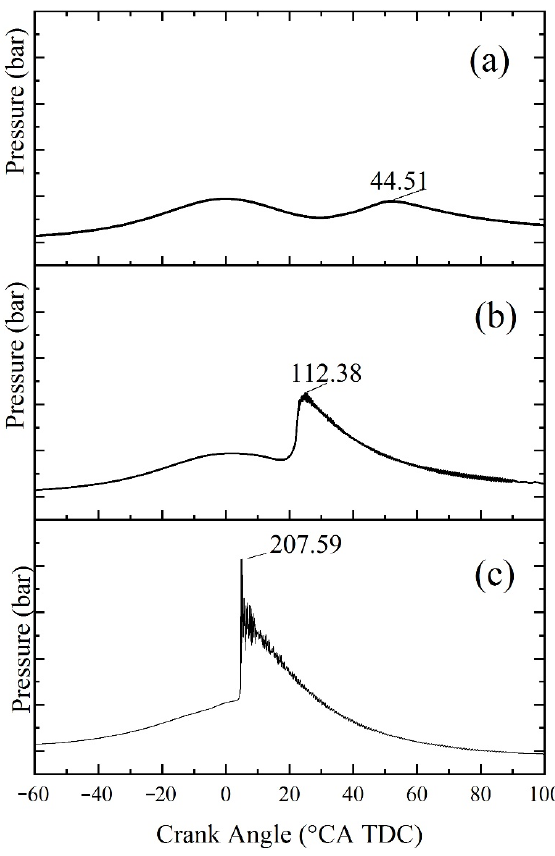
Figure 17. The in ‐ cylinder pressure curves of cylinder 3: ( a ) pressure without fluctuation; ( b ) pres ‐ sure with slight fluctuation; ( c ) pressure with severe fluctuation. with slight fluctuation; ( c ) pressure with severe